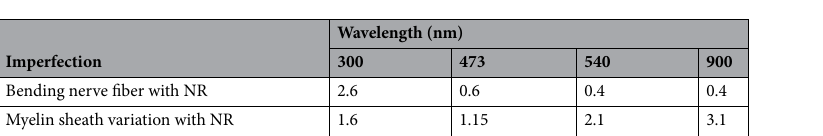
Table 6. Orders of magnitude the transmission for typical wavelengths in a bending nerve fiber and myelin sheath variation with NR compared to a normal nerve fiber when light launched to Myelin.